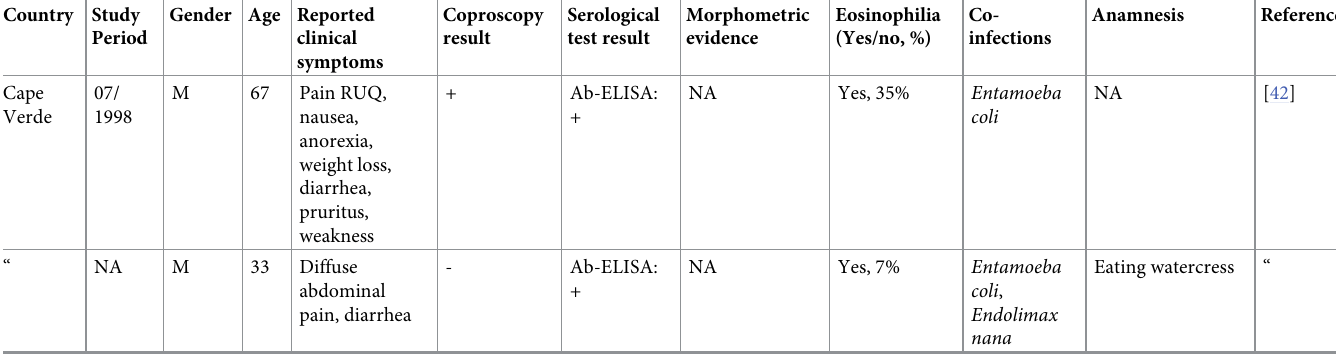
Table 3. Case reports retrieved in a systematic review on human fascioliasis in